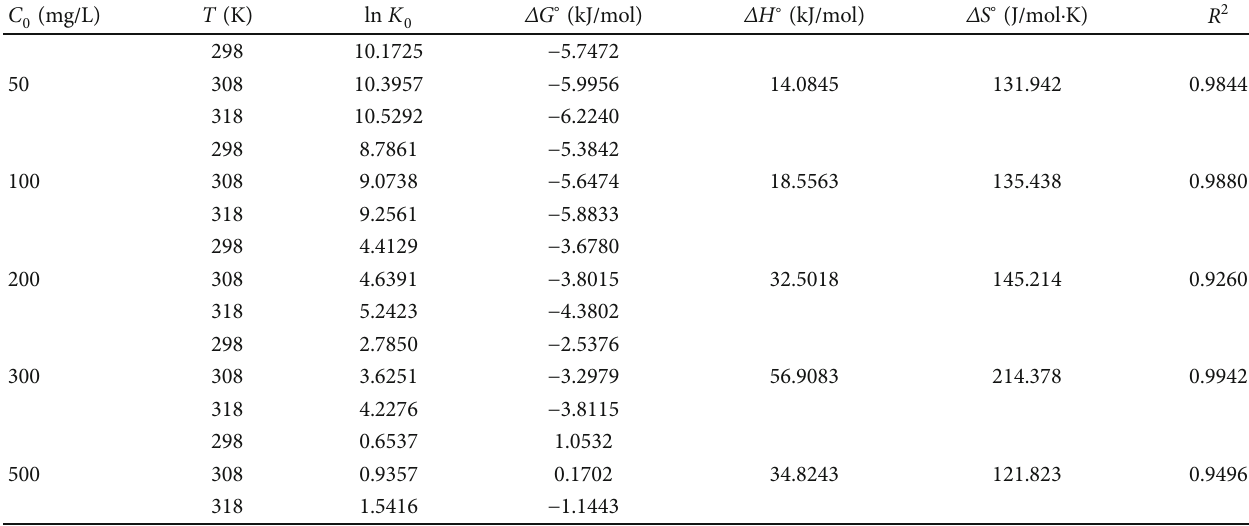
Table 4: Thermodynamic parameters for the adsorption of CV onto